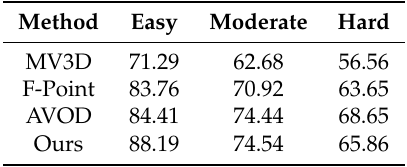
Table 1. 3D detection performance: Average precision (AP) (in %) for 3D boxes.